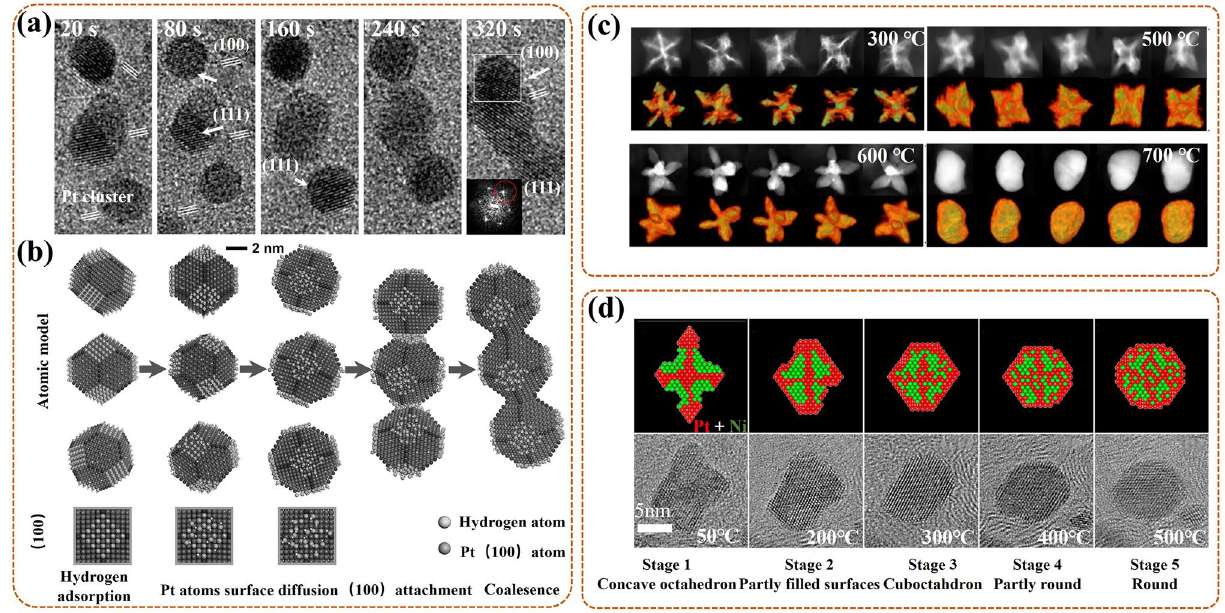
Fig. 7 a In-situ TEM images at 20 s, 80 s, 160 s, 240 s, 320 s, and b the corresponding oriented attachment schematics, for the formation of Pt-NW [117]; Reused with approval; Copyright 2017 WILEY-VCH Verbg GmbH&Co. KGaA, Weinheim. c In-situ TEM images of single Pt–Cu NF with 3D visualization at 300 °C, 500 °C, 600 °C, 700 °C, with Pt (red), Cu (green), and orange derived from color overlay [96]; Reused with approval; Copyright 2021 Elsevier Ltd. d The schematics (upper) of Pt (red) and Ni (green) distributing, and the corresponding in-situ HRTEM images (bottom) of PtNi 1.5 NP at 50 °C, 200 °C, 300 °C, 400 °C, 500 °C [118]. Reused with approval; Copyright 2018 American Chemical Soci- ety. (Color figure